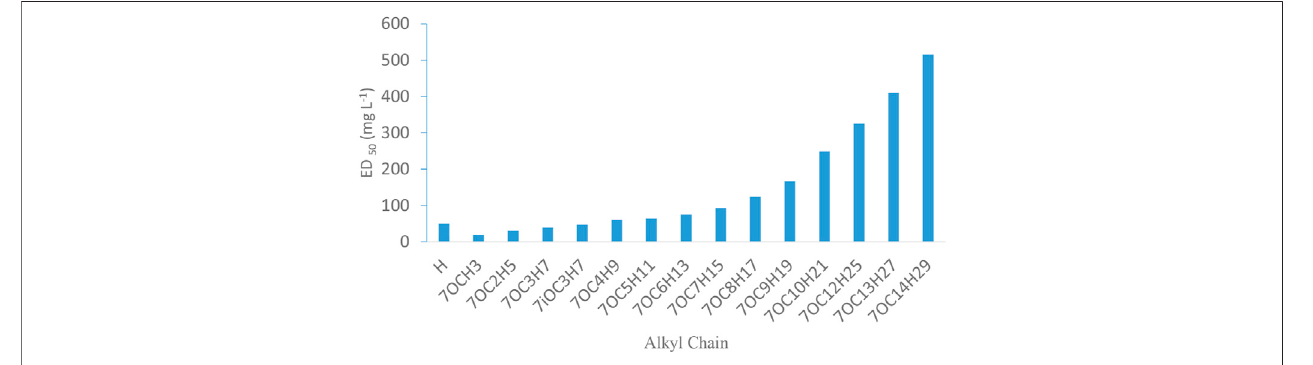
FIGURE 3 | Effect of increase in alkyl chain on fungicidal activity of